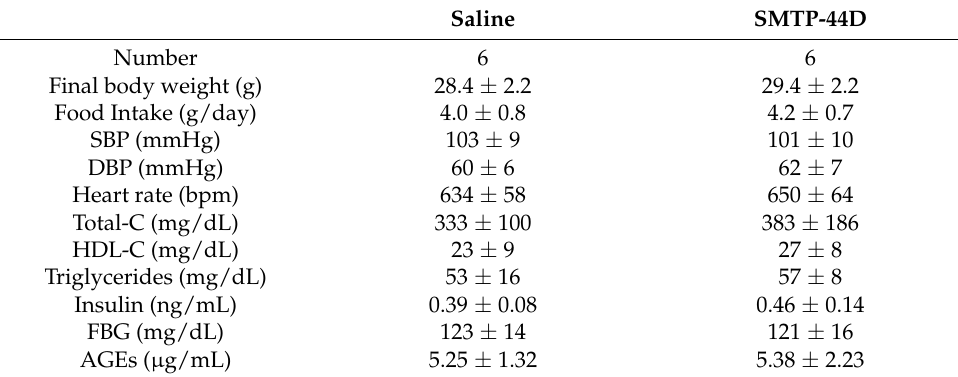
Table 1. Clinical characteristics of 21-week-old Apoe − / − mice injected with SMTP-44D or saline for 4